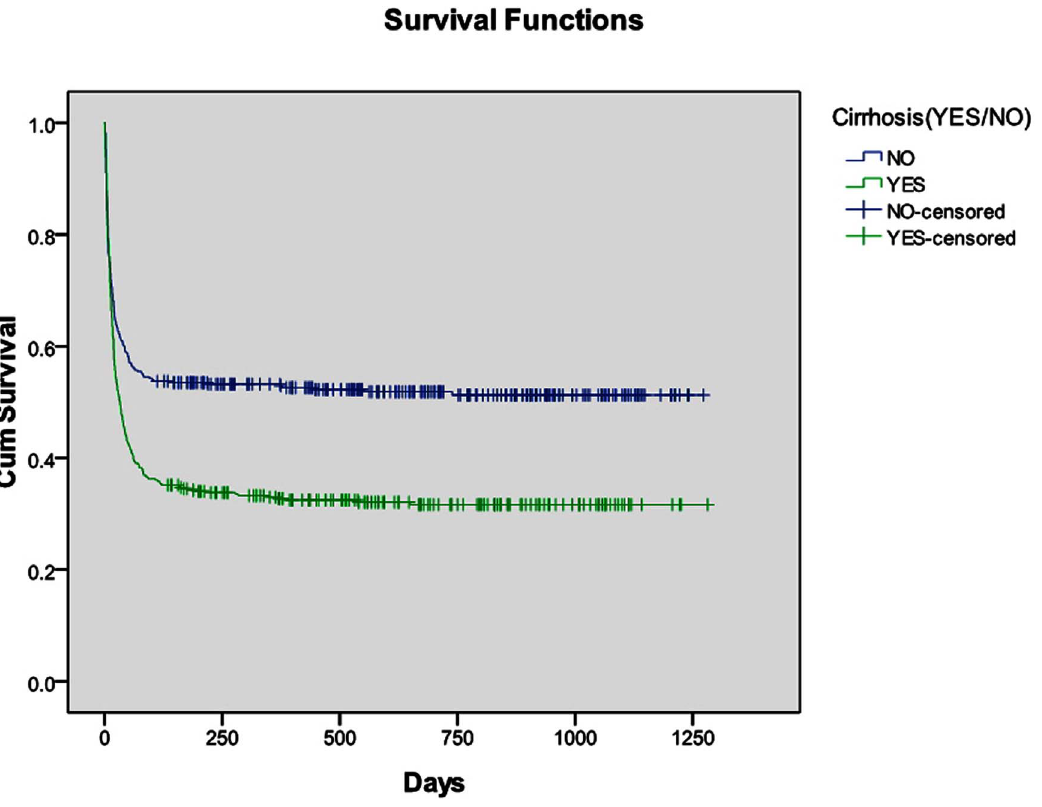
Figure 3. Survival comparison of patients with and without cirrhosis. The difference in survival between patients with cirrhosis and without cirrhosis was statistically significant (P , 0.0001).